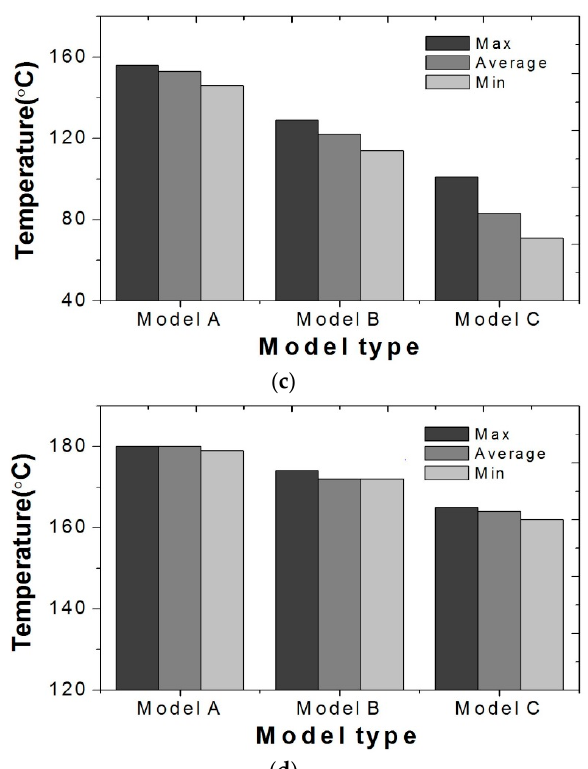
Figure 5. Total temperature of heater, ( a ) Temperature contour for different heat rod interval, ( b ) temperature on air outlet, ( c ) temperature in fin, ( d ) temperature in PTC.